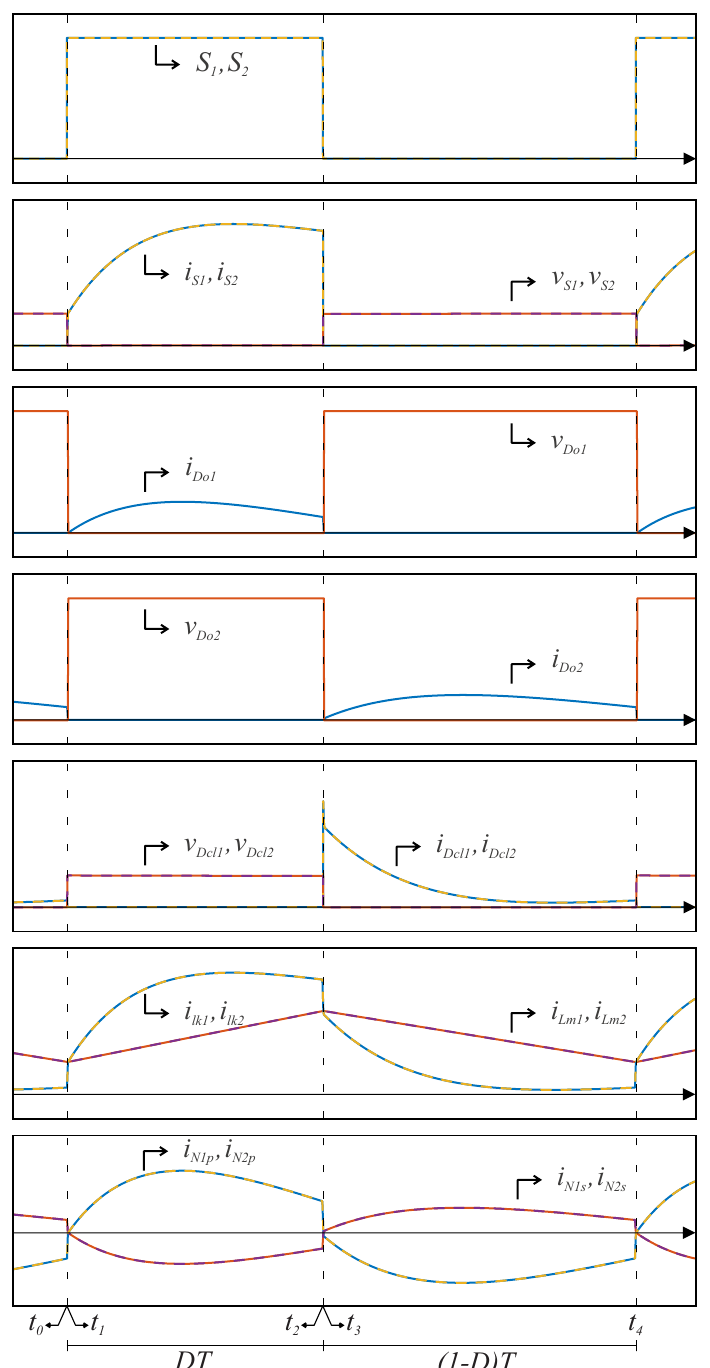
Figure 2. Converter main current and voltage waveforms during a switching